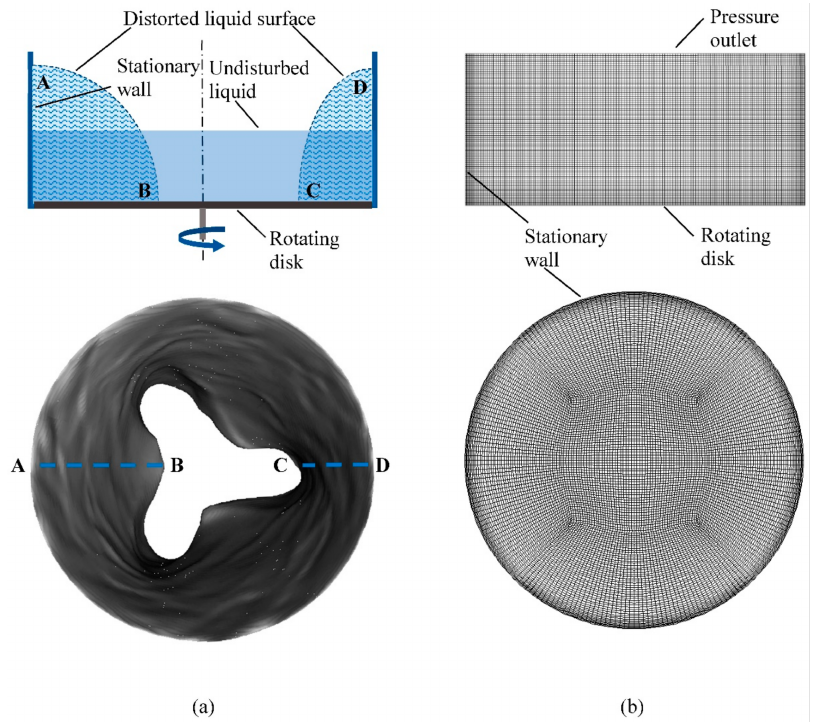
Figure 1. The system addressed in the present study: ( a ) physical model and an example of a polygon created on the disk surface; ( b ) computational domain and grid (front and top